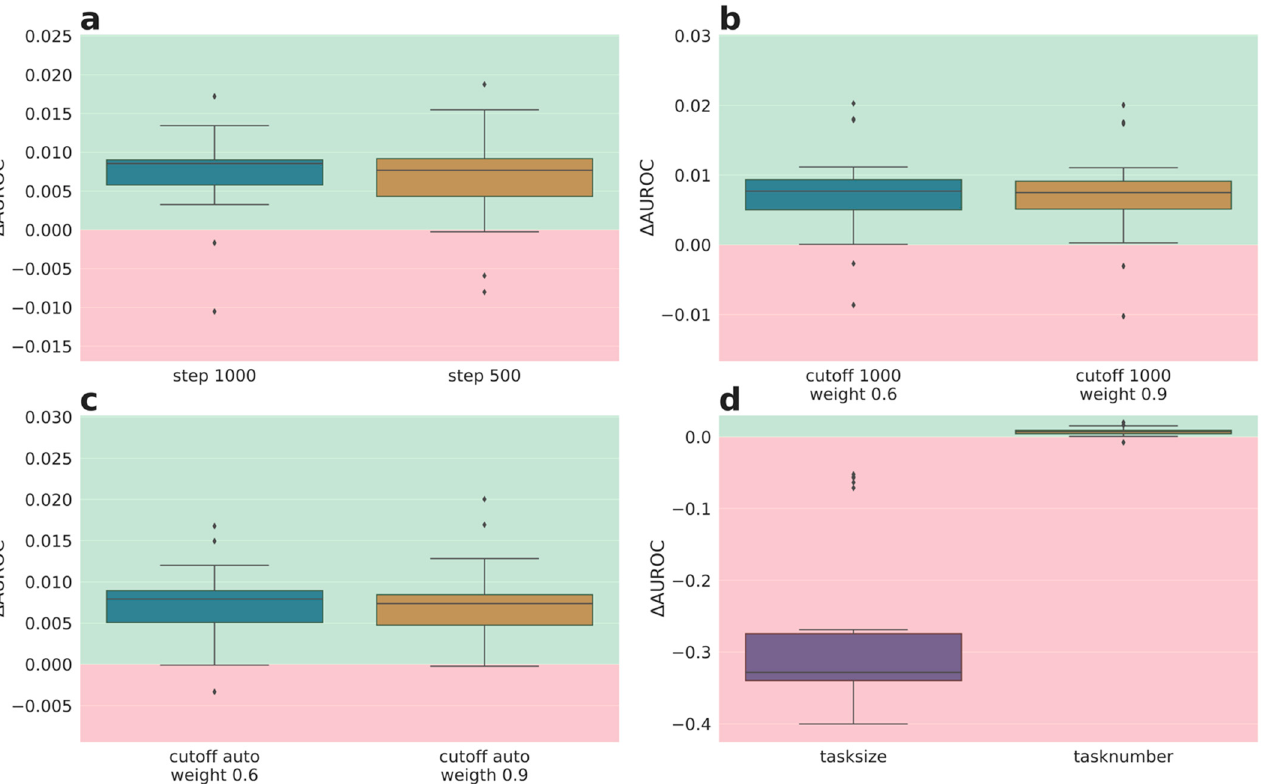
Figure 2. Phase II results of different weighting schemes averaged over 5 partners and 5 folds for lower quartile task (AUROC): ( a ) continuous weighting scheme with weight 0.02 and steps left: 1000 and right: 500, ( b ) fixed weighting scheme with cutoff 1000 and left: weight of 0.6 and right: weight of 0.9, ( c ) fixed weighting scheme with 95% quantile cutoff and left: weight 0.6 and right: weight 0.9, ( d ) left: weighting based on task size, right: weight set to one divided by number of datapoints. Green: better performance than baseline (1), red: worse performance than baseline.